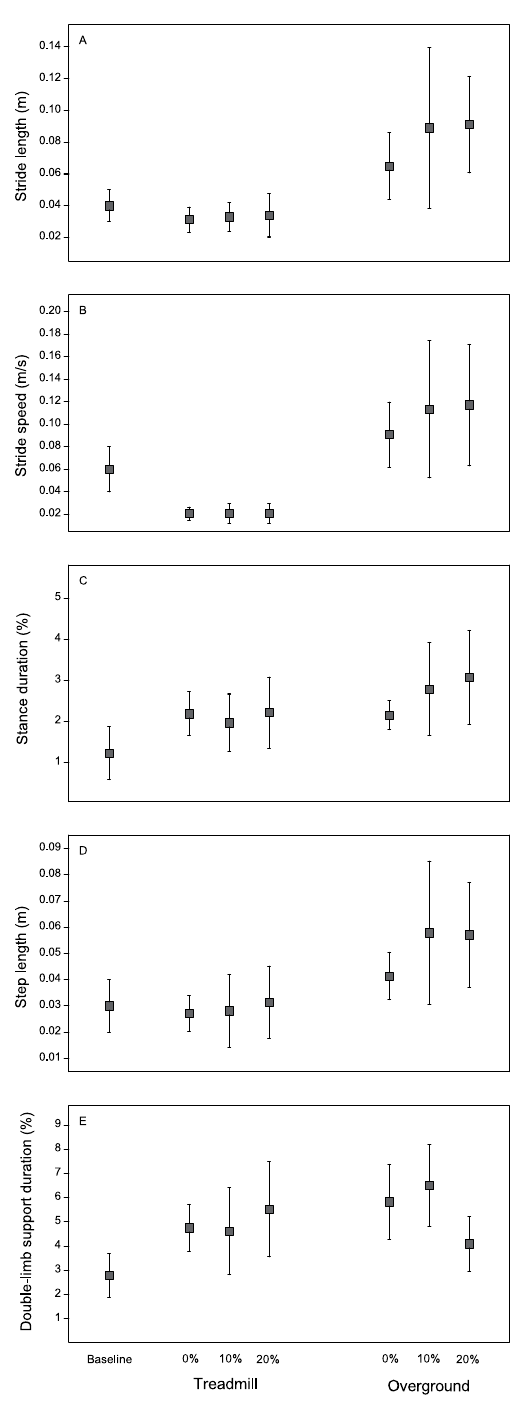
Figure 2. Mean and standard deviations for variability in stride length ( A ), stride speed ( B ), percentage of stance duration ( C ), step length ( D ), and percentage of total double-limb support ( E ) at the baseline, 0%, 10%, and 20% of BWS on both treadmill and over the ground. Note: data from baseline are presented only as reference